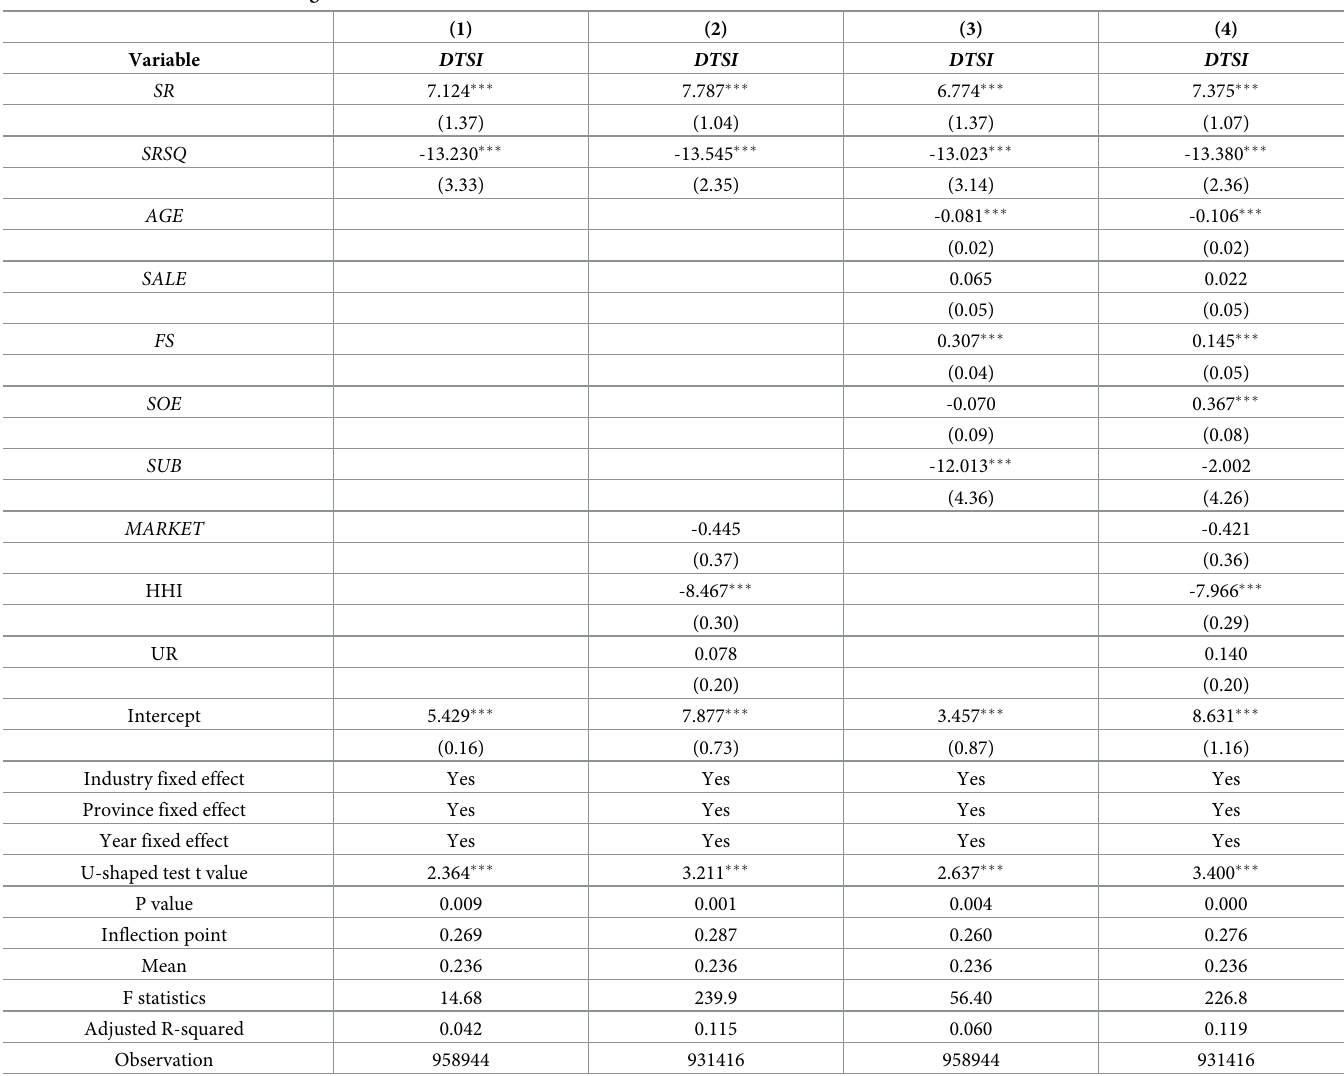
Table 3. The results of benchmark